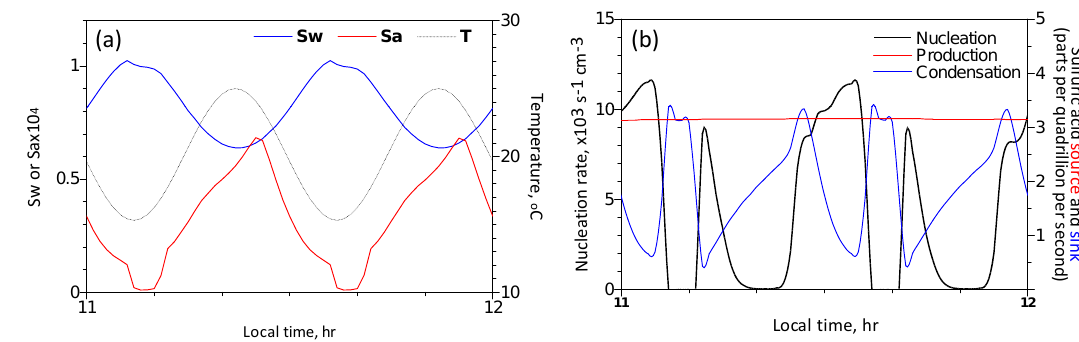
Fig. 10. Evolution of (a) relative humidity S w , relative acidity S a (x10 4 ) and temperature T ; (b) nucleation rate (in per unit volume and unit time; black curve), as well as rates (in parts per quadrillion by volume per second) of photochemical production (red curve) and condensation (blue curve) of sulfuric acid vapor for the case of Q = 1 in Fig. 9. Time length shown is the same as in Fig.